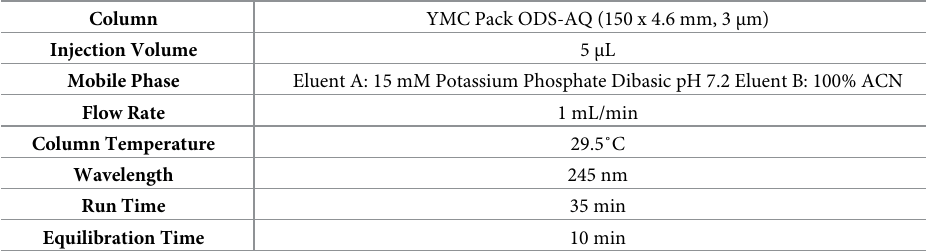
Table 2. Summery of method parameters.